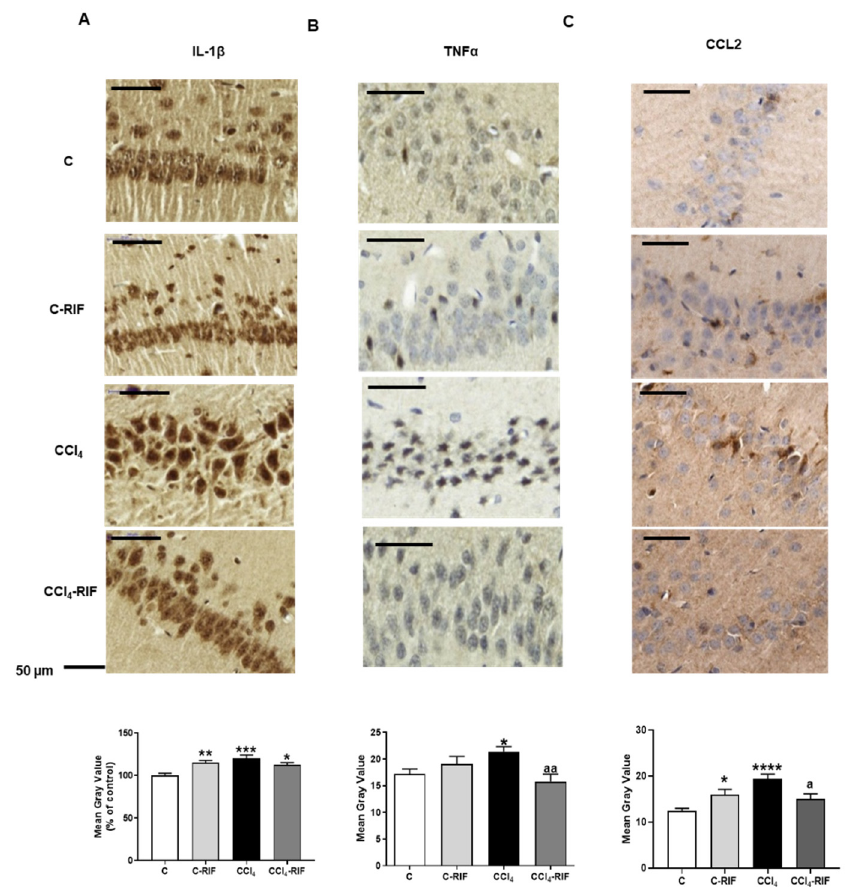
Figure 2. IL-1 β ( A ), TNF α ( B ), and CCL2 ( C ) content in CA1 region of hippocampus. It was analyzed by immunohistochemistry. The quantification was expressed according to the mean on the grey scale (Mean Grey Value) and as percentage of control rats for IL-1 β quantification. Values are the mean ± SEM of 6 rats per group. The data were analyzed using a one-way ANOVA and Tukey’s multiple comparisons test. The asterisks indicate a significant difference compared to the control group * p < 0.05, ** p < 0.01, *** p < 0.001, **** p < 0.0001; “a” compared to the CCl 4 rats “a” p < 0.05, “aa” p < 0.01.